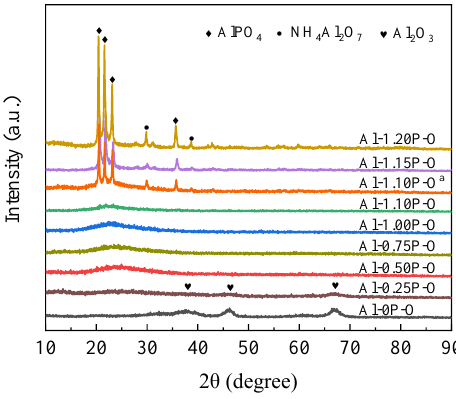
Figure 2. XRD patterns of Al- x P-O and Al-1.1P-O a samples. Table 1. The textural properties of Al- x P-O and Al-1.1P-O a samples.